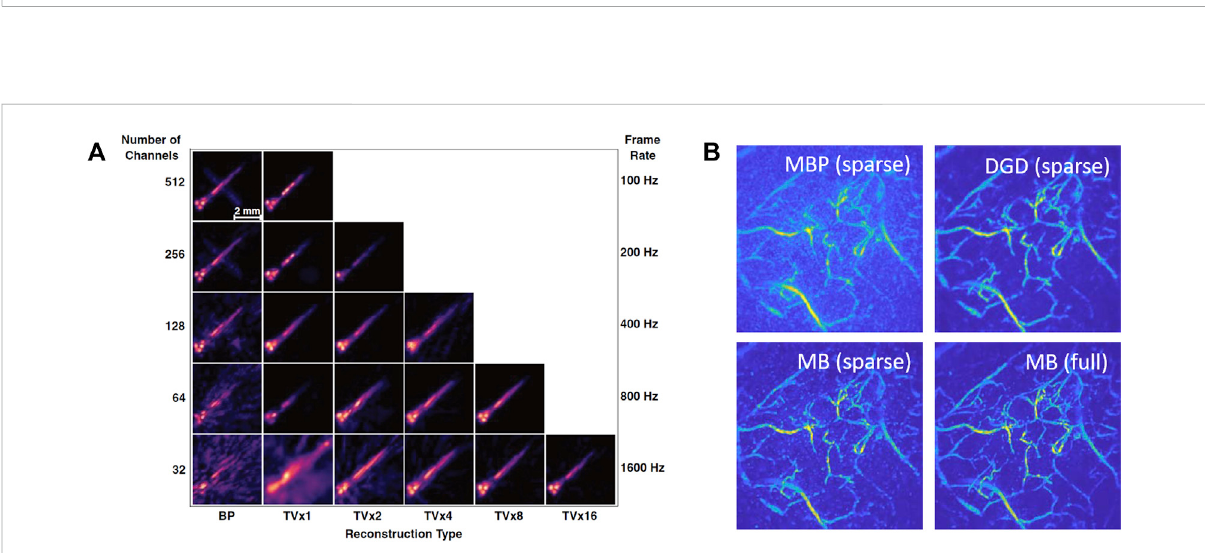
FIGURE 3 Model-based (MB) reconstruction from sparse data based on advanced regularization methods. (A) Performance of three-dimensional MB reconstruction based on total-variation (TV) regularization in the spatial and temporal domains. As a reference, the images reconstructed with fi ltered back-projection (FBP) are shown in the left column as a function of the number of time-resolved signals considered. The equivalent MB images are shown in theother columns. TVxN indicates that a sequence ofN imagesis simultaneously reconstructed. Reprintedfrom [99]with permissionfromOpticaPublishingGroup. (B) Performanceofthedeepgradientdescent (DGD)algorithmwhenconsideringsignalssub-sampledby a factor of 4 in the spatial and temporal domains. The image obtained with DGD after 5 iterations (top right) is compared to the image obtained with the model back-projection (MBP) method (1 iteration, top left) and iterative TV-based MB algorithm (20 iterations, bottom left). As a reference, the image reconstructed with the same TV-based MB algorithm (20 iterations) from the full data is also shown (bottom right). Adapted from [101] with permission from Institute of Electrical and Electronics